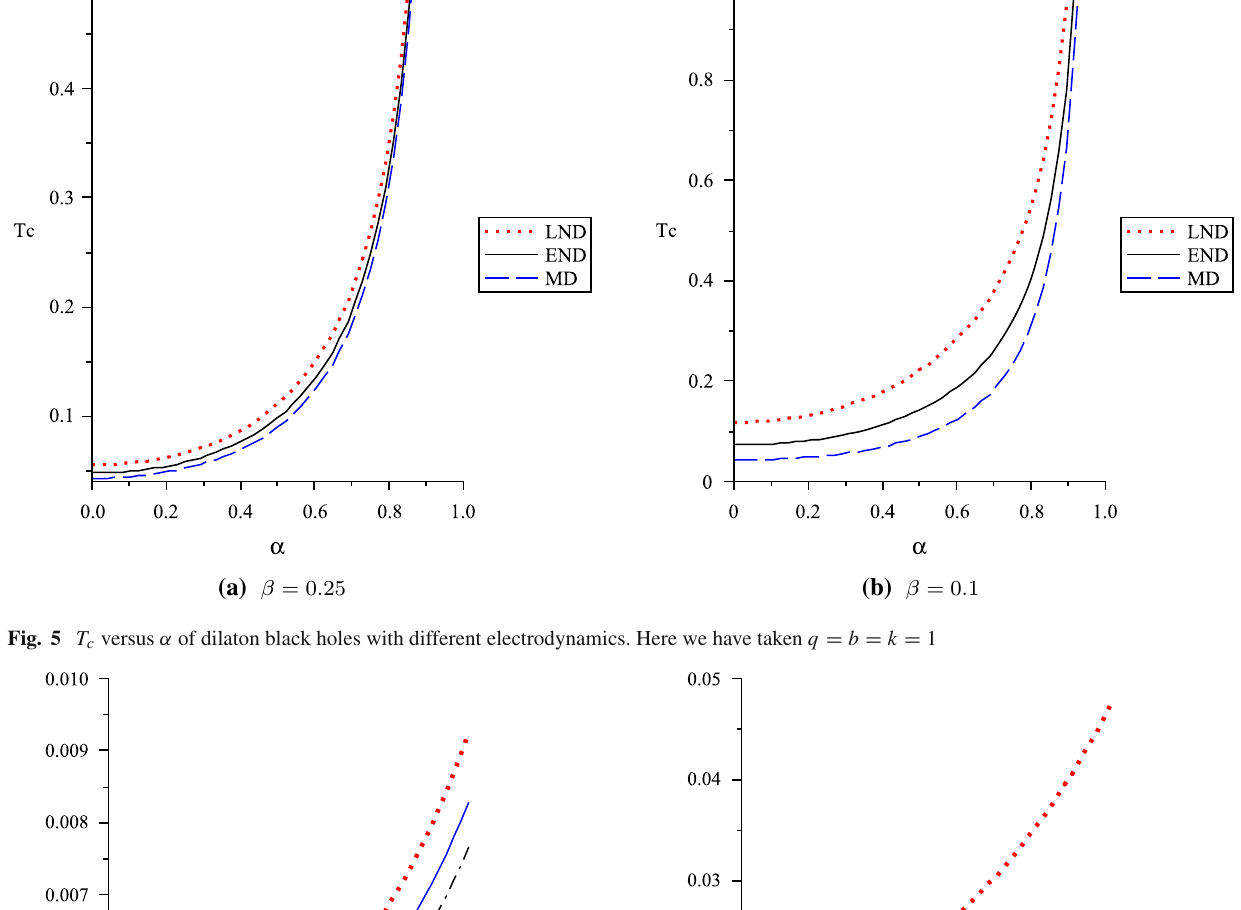
Fig. 5 T c versus α of dilaton black holes with different electrodynamics. Here we have taken q = b = k = 1